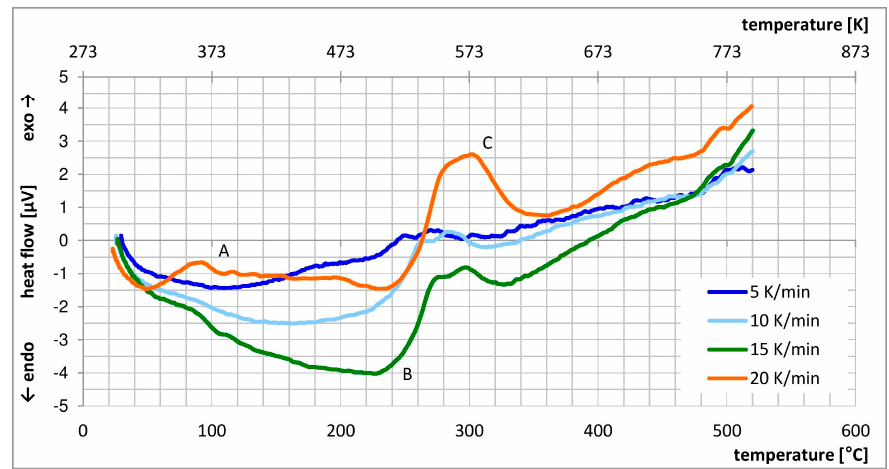
Figure 16. DSC curve used for finding the solution annealing temperature.